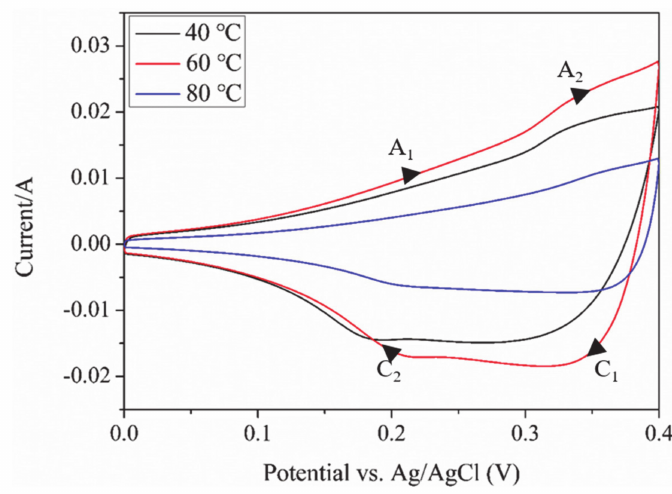
Figure 6. CV of the electrodes prepared with di ff erent anodizing temperature at 20 mV s − 1 scan